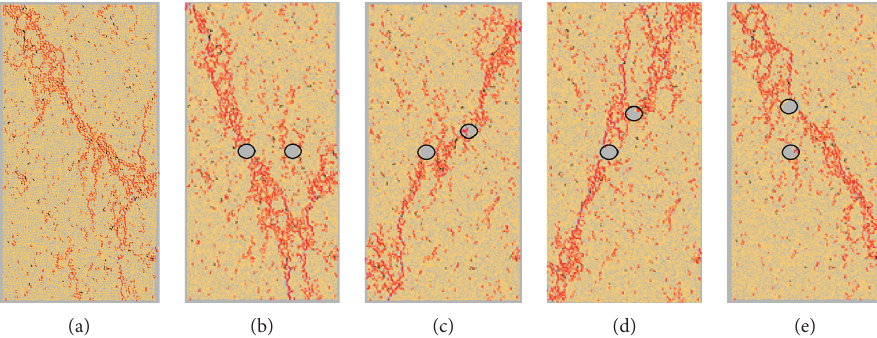
Figure 16: Macrofracture morphology of coal sample with different hole angle. (a) Intact coal specimen, (b) β � 0, (c) β � 30 ° , (d) β � 60 ° , and (e) β � 90 ° .